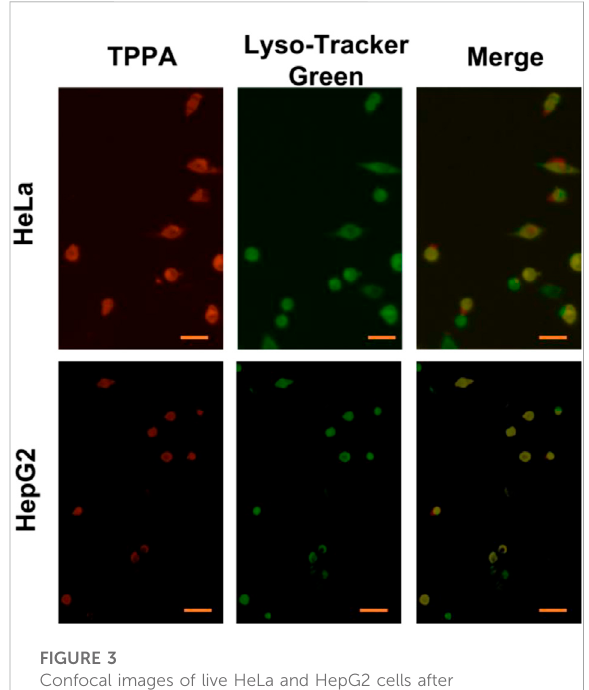
FIGURE 3 Confocal images of live HeLa and HepG2 cells after incubation with TPPA (5.00 × 10 − 4 M) for 4 h. Scale bar is 50 μ